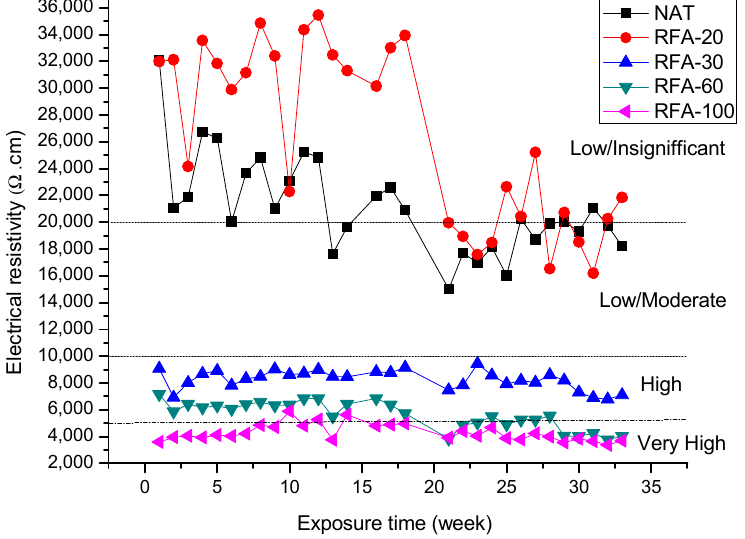
Figure 9. Evolution of ρ for the mixtures with RFA.